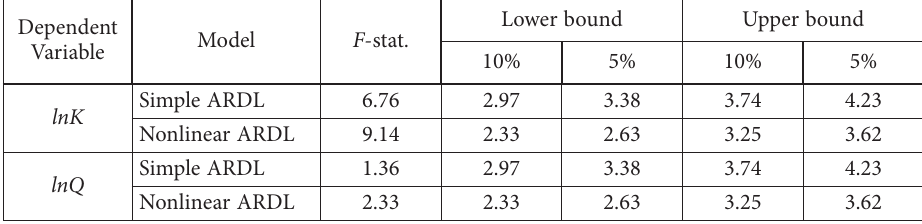
Table 3. Cointegration bound test